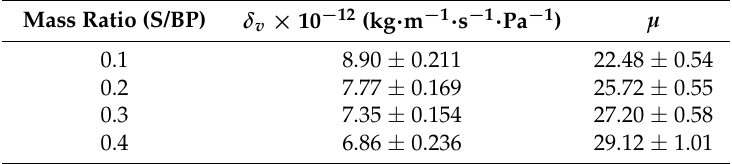
Table 4. Permeability and resistance to water vapor of S-BP